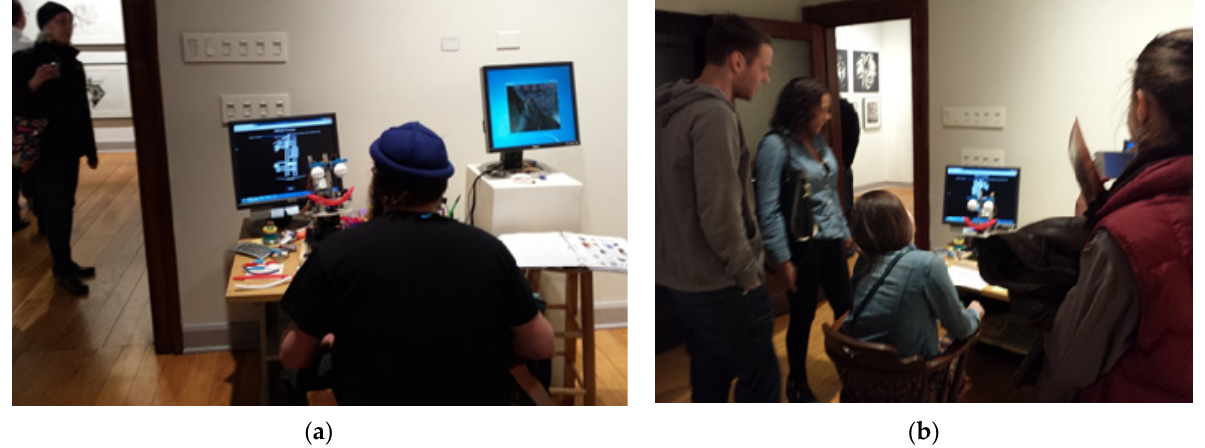
Figure 1. Examples ( a , b ) of human–robot interaction during a public art museum exhibit. Using video images from its onboard camera, the robot calculated dense optical flow to detect motion on a 120 × 120 pixel grid using OpenCV (https://opencv.org/, accessed 28 February 2021). Points of maximal flow (i.e., motion) were then used as part of a visual attention system (along with face detection performed using Haar cascades), with a maximum of four stimuli being held its attention array at any given moment based on evidence of how the human visual attention system works [58]. The robot would then selectively attend to those points in its visual field. An example of this in action can be seen in Figure 2a (note that the participant’s face has been deliberately blurred in the image here, for privacy